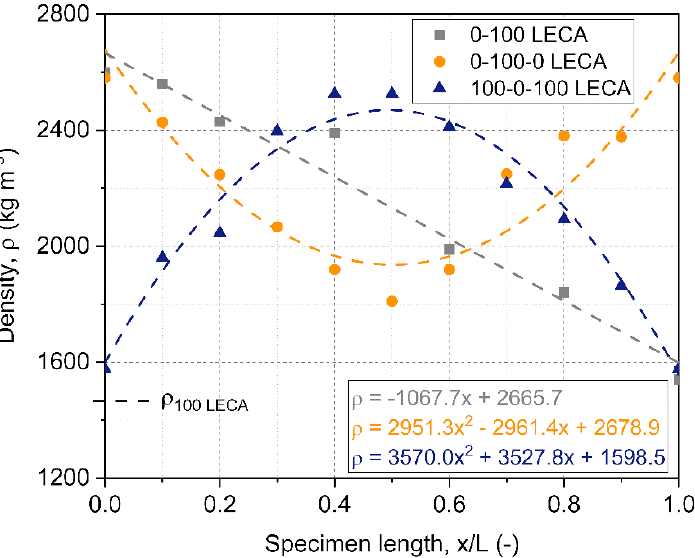
Figure 8. Density and fitted curves for modal analysis in the case of graded samples (0-100 LECA, 0-100-0 LECA, and 100-0-100 LECA).